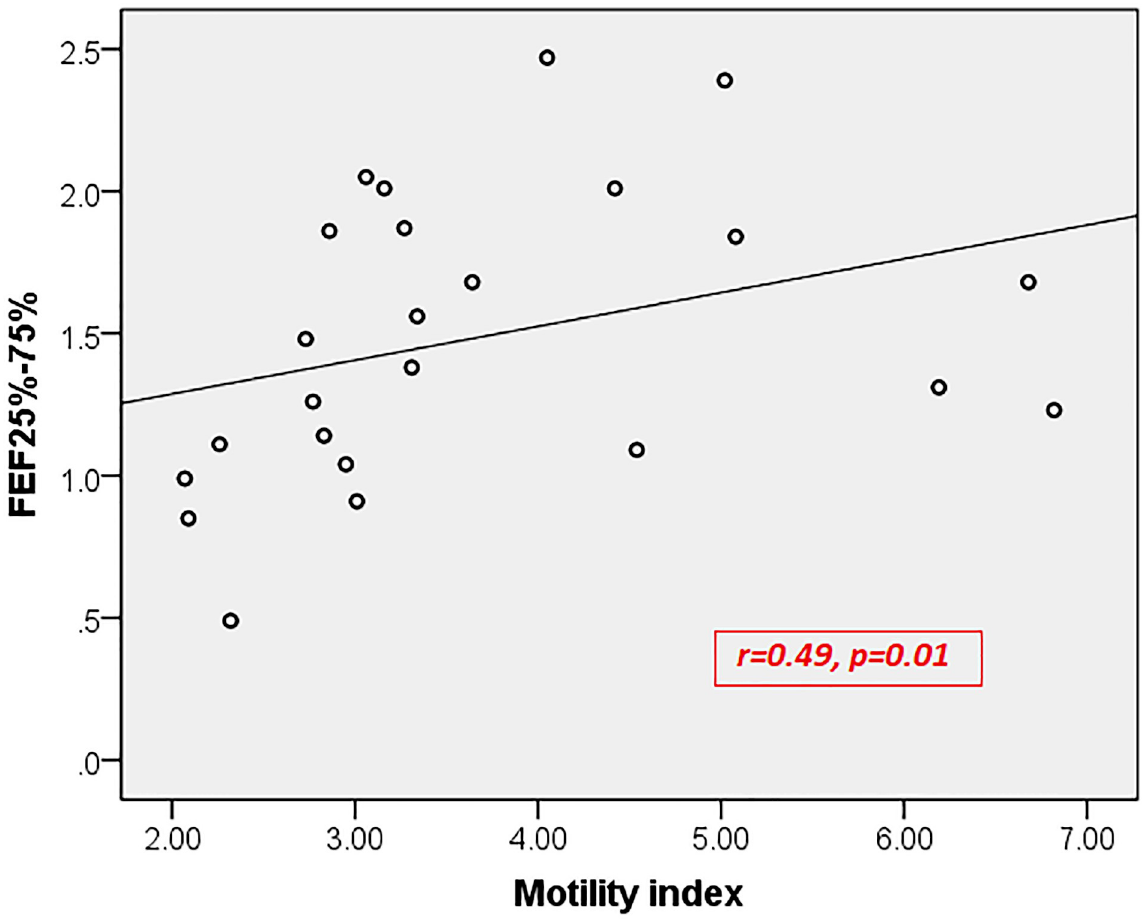
Fig 2. Correlation between motility index and FEF25-75% in children with both asthma and functional abdominal pain disorders. FEF25- 75%, Forced Expiratory Flow between 25–75%.